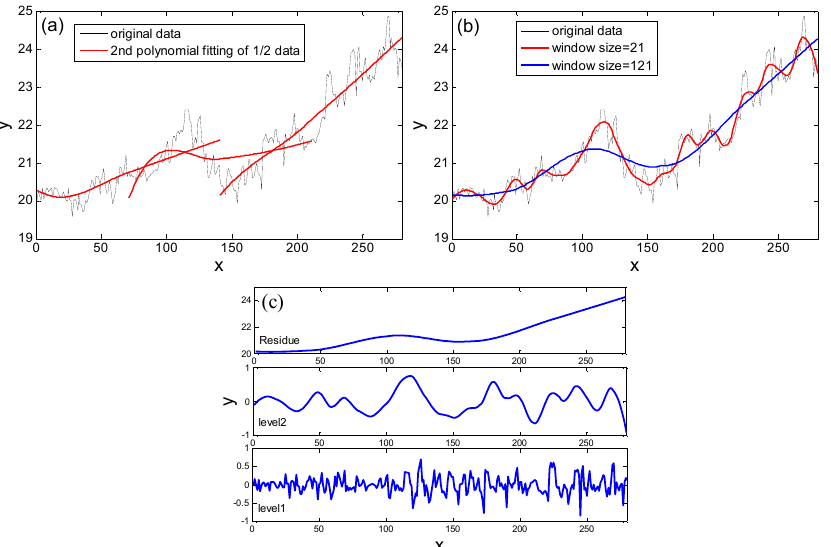
Figure 5. Schematic of data decomposition using N-AMD: ( a ) three 2nd order polynomial fitted lines, ( b ) the fitted trend with window sizes of 21 and 121, and ( c ) different frequency components of the original data using various window sizes, where Residue is the fitted trend of original data with a window size of 121, level 2 is the fitted trend of ( original data − Residue ) with a window size of 21, and level 1 is the remaining part that satisfies the relationship: original data = ( level) 1 + ( level) 2 + ( Residue).